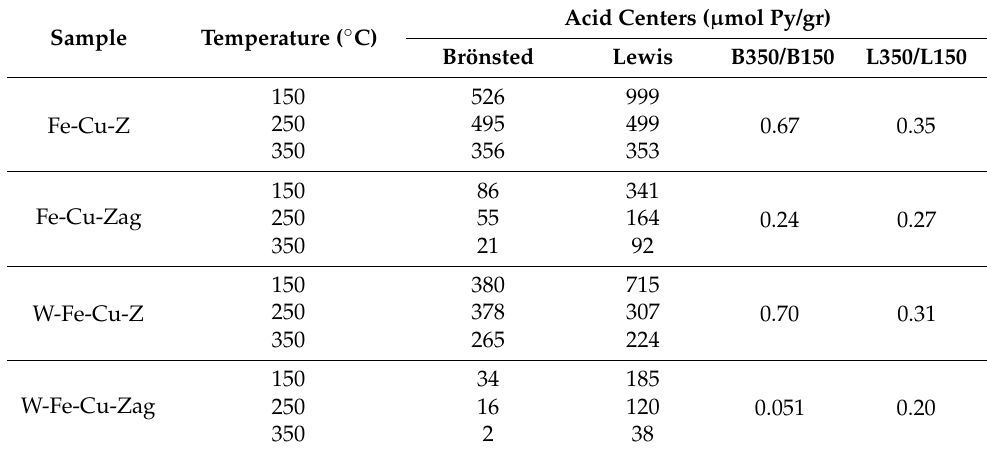
Table 4. FTIR-Pyr quantitative study of acid centers.